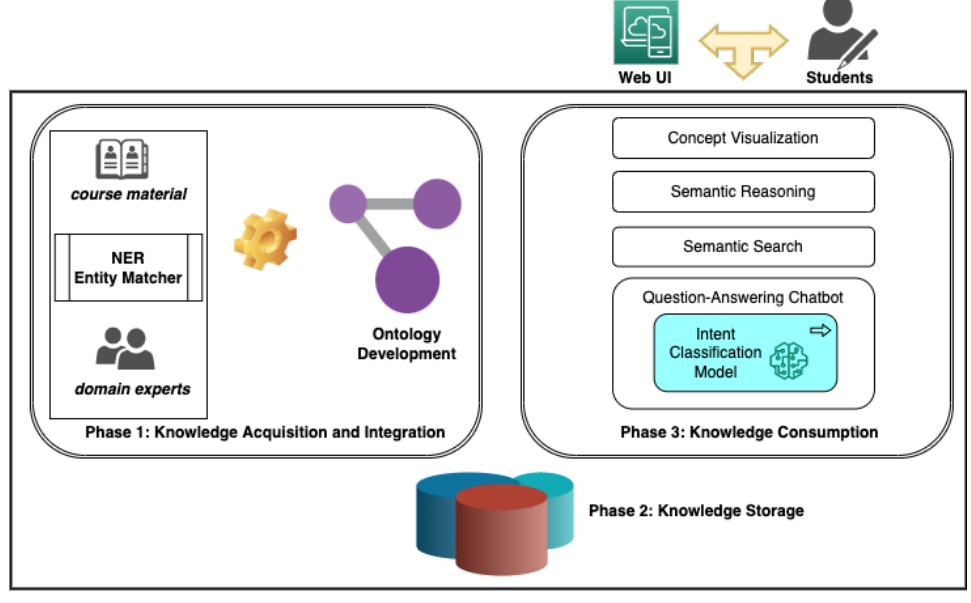
Figure 1. Architecture for Knowledge Graph as explained in Section